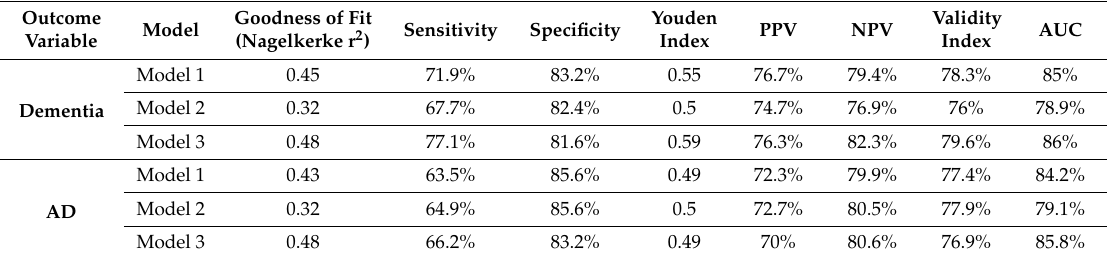
Table 4. Diagnostic accuracy of logistic regression models adjusted for dementia and AD. Outcome